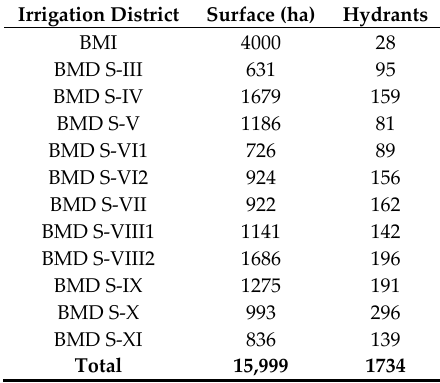
Table 1. Summary table of the irrigation sectors studied, presenting their location, the surface area irrigated and the number of hydrants that are fed by the networks